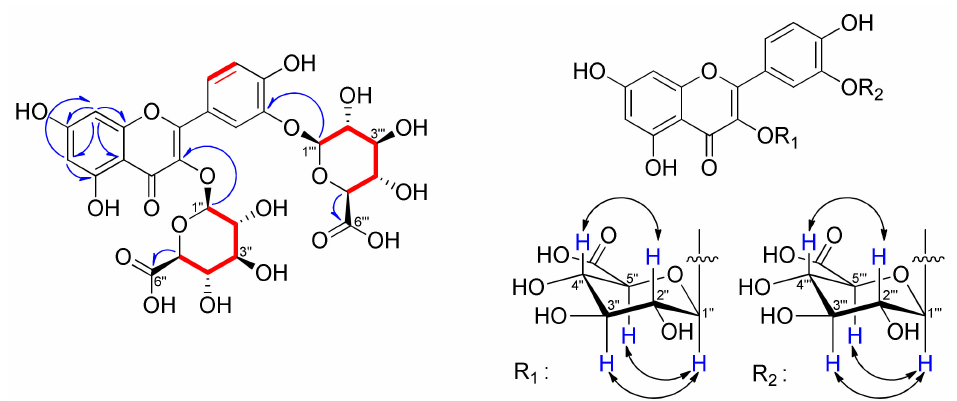
Figure 2. Key 1 H − 1 H COSY ( ), 1 H − 13 C HMBC ( ) and 1 H − 1 H NOESY ( ) correlations of compound 1